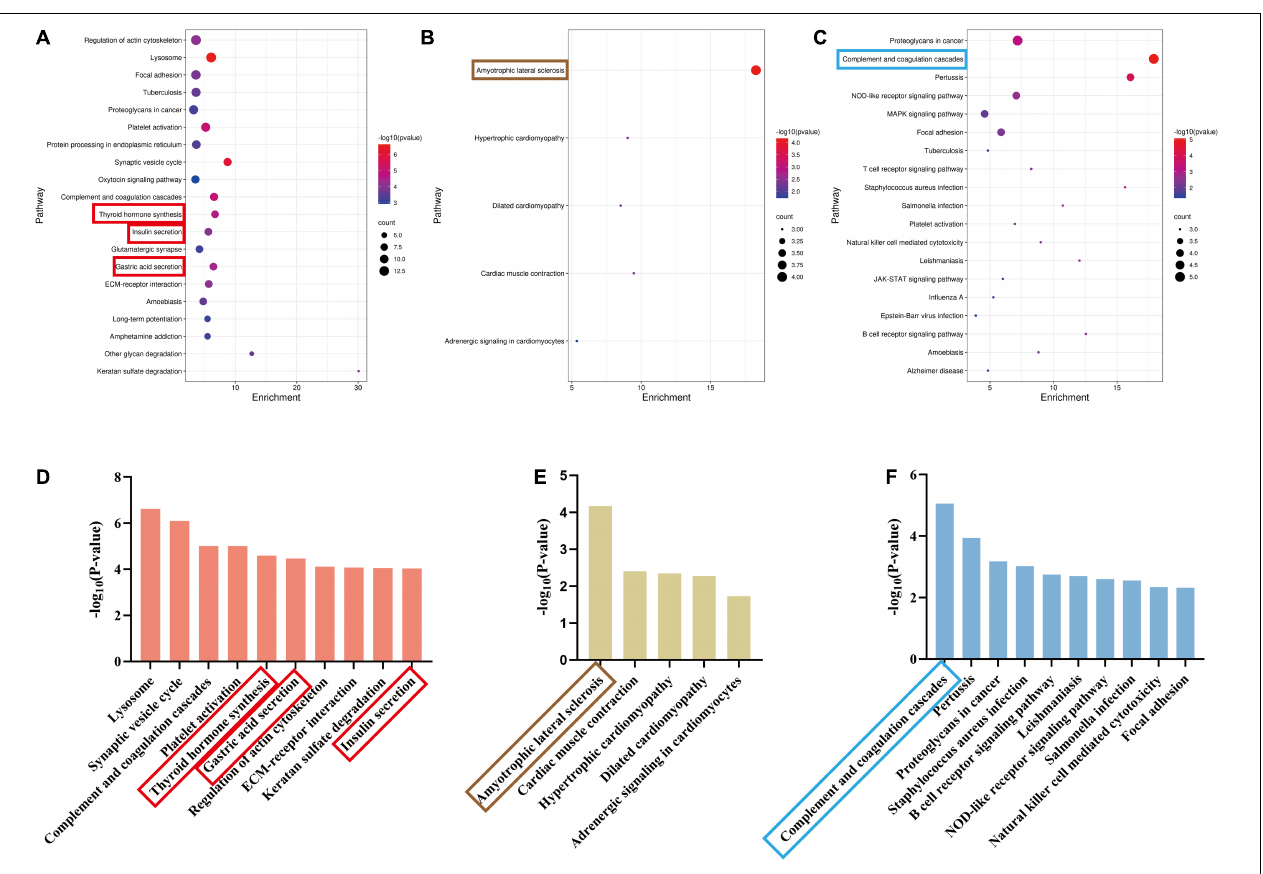
FIGURE 7 | Significant pathways of acute and recovery stages of TBI. ( p < 0.05). (A) The significant pathways in the Sham-a/CCI-a groups (excluding 63 shared DEPs). The ordinate represents pathways. (B) The significant pathways in the Sham-s/CCI-s groups (excluding 63 shared DEPs). The ordinate represents pathways. (C) The significant pathways of 63 shared DEPs. The ordinate represents pathways. (D) The top ten significant pathways in the Sham-a/CCI-a groups. (E) The top 10 significant pathways in the Sham-s/CCI-s groups. (F) The top 10 significant pathways of 63 shared DEPs. The red rectangle represents three endocrine-related pathways; brown rectangle, amyotrophic lateral sclerosis; blue rectangle, complement, and coagulation